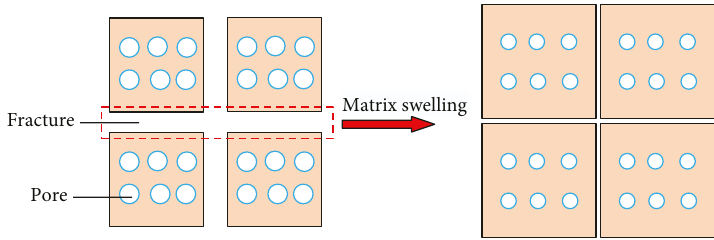
Figure 15: Schematic diagram of porosity reduction.